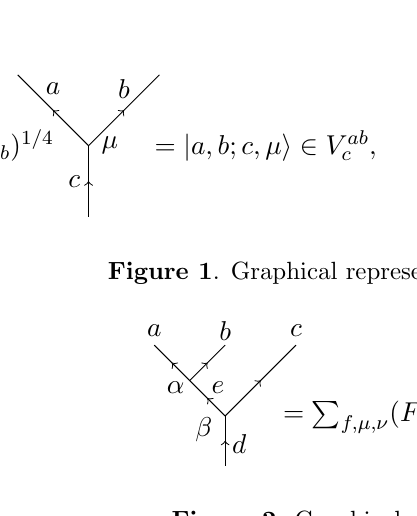
Figure 2 . Graphical representation of F